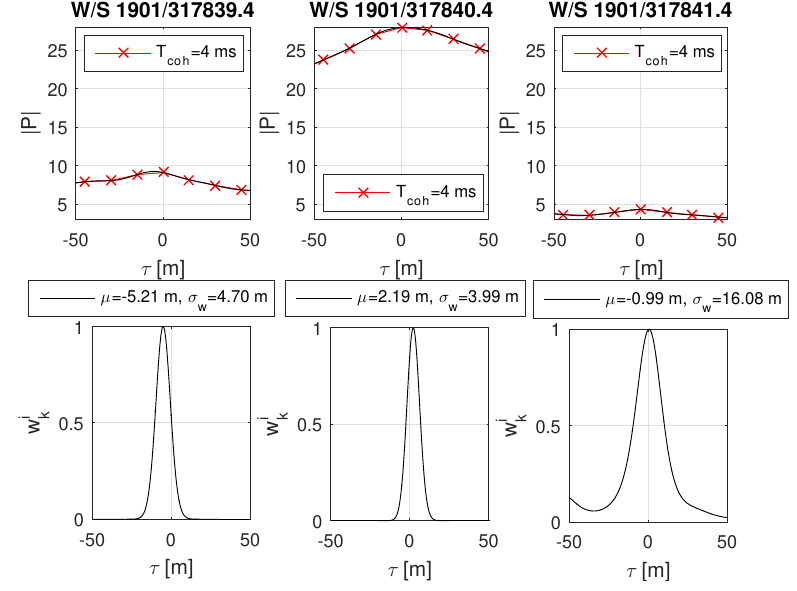
Figure 16. Real-world urban scenario of satellite GPS L1 C/A PRN 18. The plot content is analogical to Figure 14. This satellite signal is significantly affected by the environment. From the azimuth of satellite PRN 18 and the location of the buildings as shown in Figure 17, it can be assumed that the GNSS signal is blocked at the first and last positions, which fits to the amplitude of the correlation values. Interestingly, in the case of the third position, the significantly small correlation value leads to an increase in variance